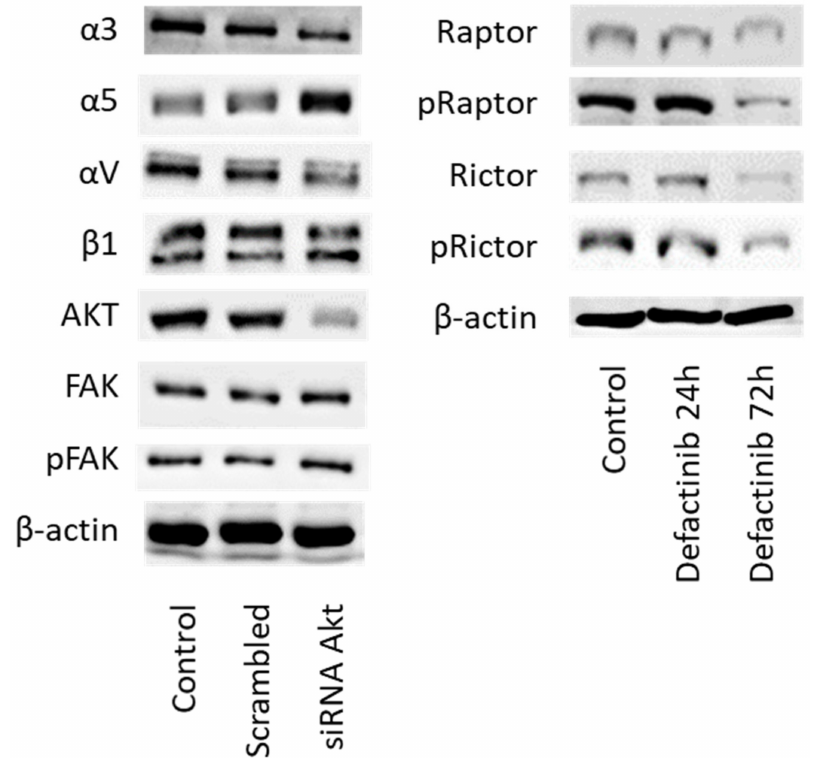
Figure 15. ( Left ) Integrin subtype and FAK expression level in DU145 cells following treatment with Akt specific siRNA (versus untreated controls or scrambled siRNA). ( Right ) mTOR signaling in DU145 cells following defactinib treatment for 24 and 72 h. Controls remained untreated. One representative of three separate experiments is shown. Each protein analysis was accompanied by a β -actin loading control. One representative internal control is